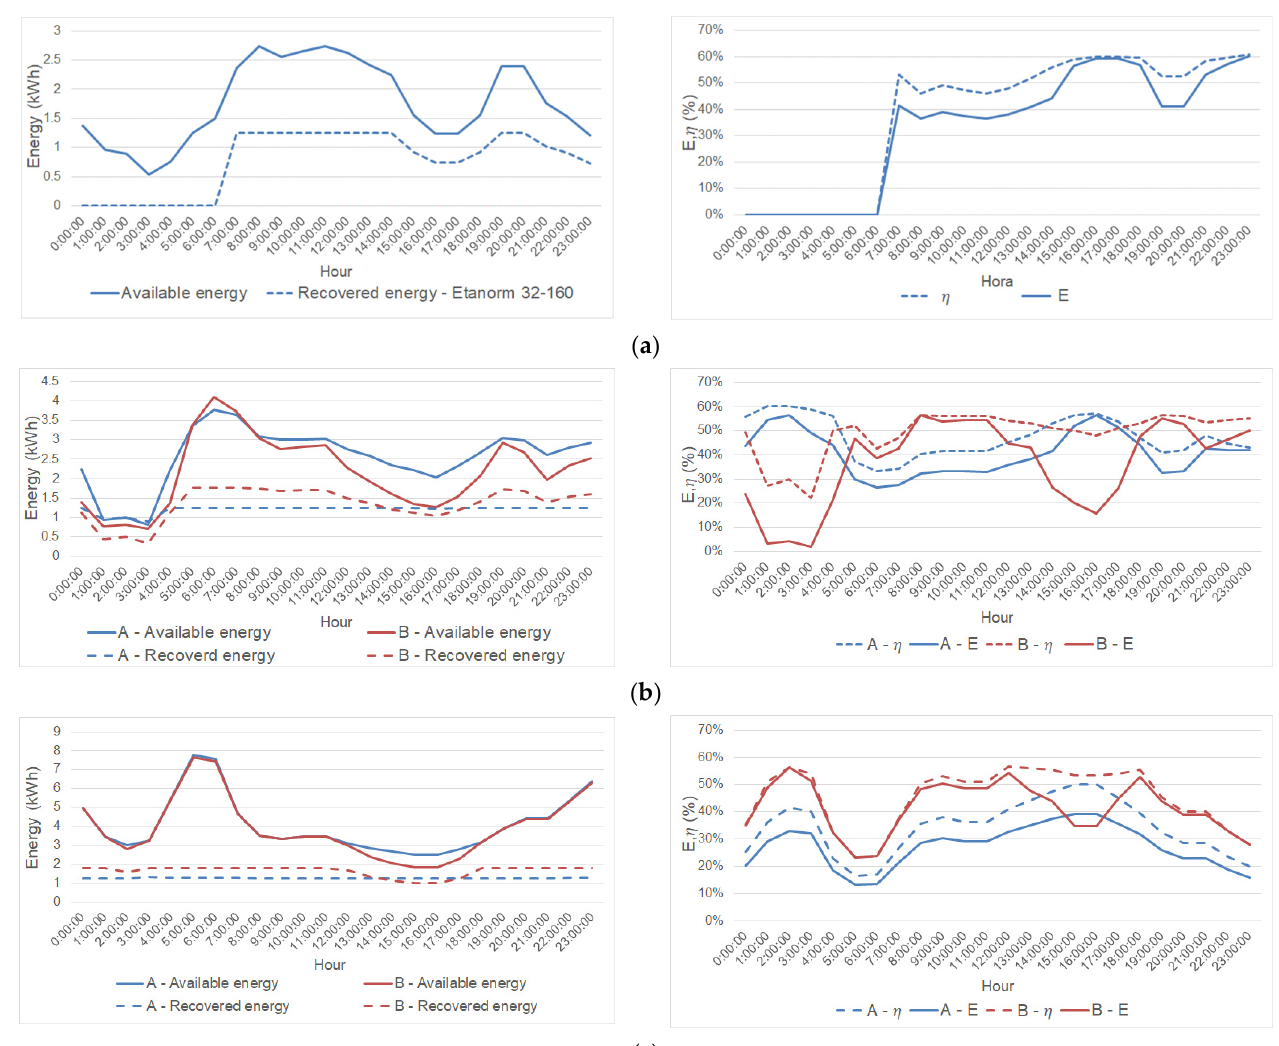
Figure 14. Available and recovered energy for different demand patterns type (left) and effectiveness (E) and capability ( η ) ( right ) : ( a ) normal; ( b ) high; ( c ) very high consumption scenarios.